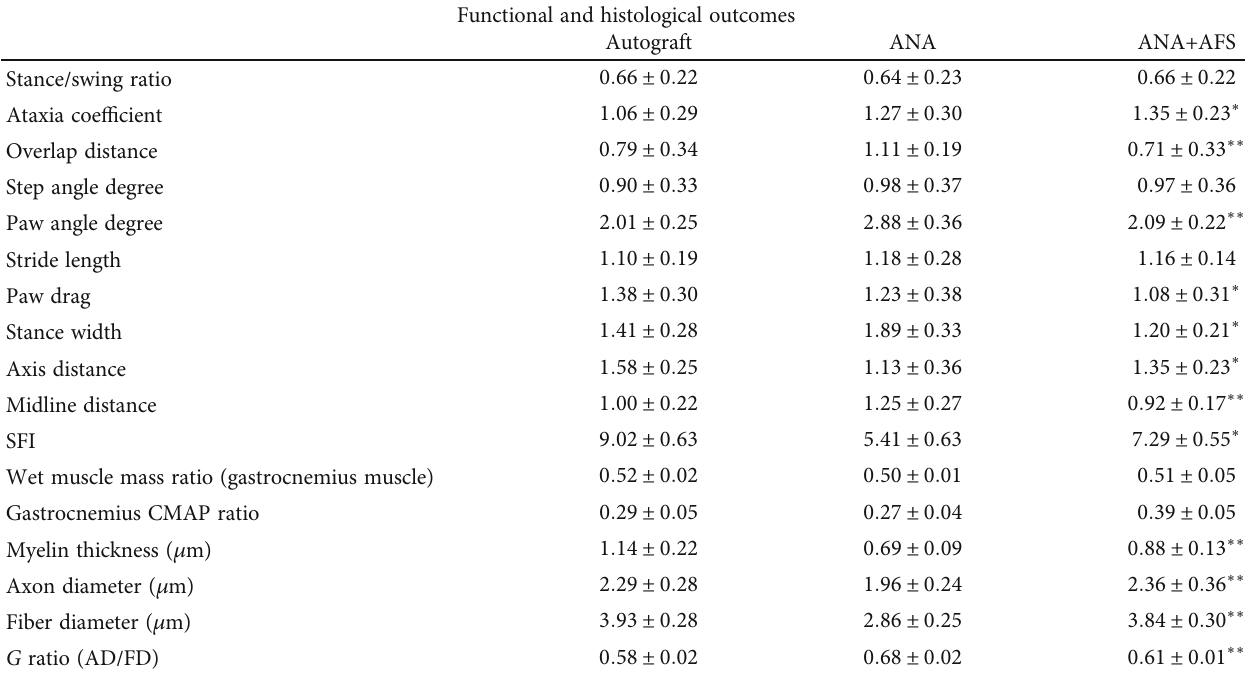
Table 1: Summary of functional and histological outcomes in 3 experimental groups. ∗∗ p < 0 : 01 and ∗ p < 0 : 05 , signi fi cantly di ff erent to the ANA